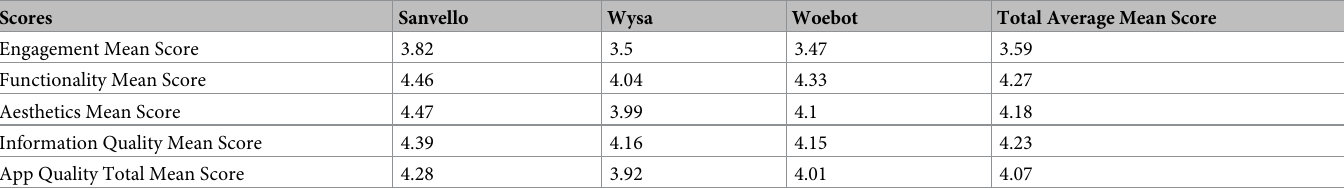
Table 4. User version of the Mobile App Rating Scale scores.